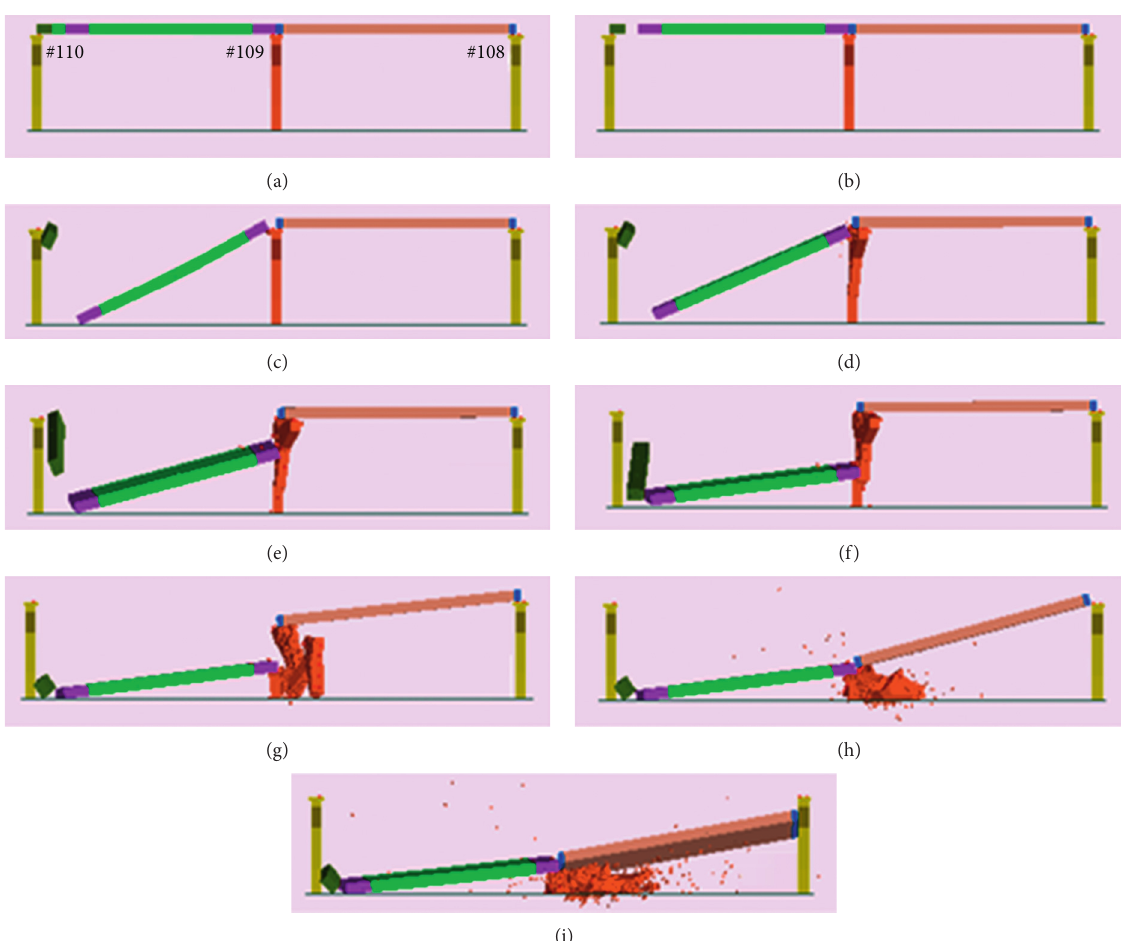
Figure 5: Graphical representation of the collapse procedure at (a) t � 0.00s, (b) t � 0.10s, (c) t � 1.24s, (d) t � 1.34s, (e) t � 2.10 s, (f) t � 3.03 s, (g) t � 5.18s, (h) t � 5.82s, and (i) t � 6.22s.